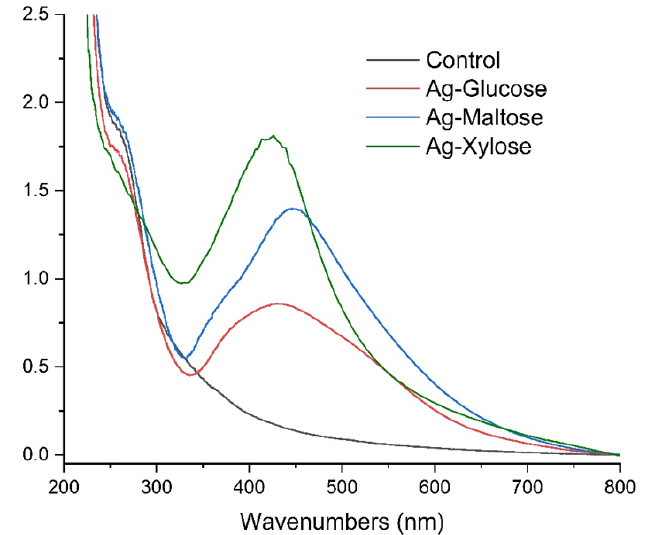
Figure 3. UV–Vis spectra of control (black line), Ag-xylose (green line), Ag-maltose (blue line) and Ag-glucose (red line) .